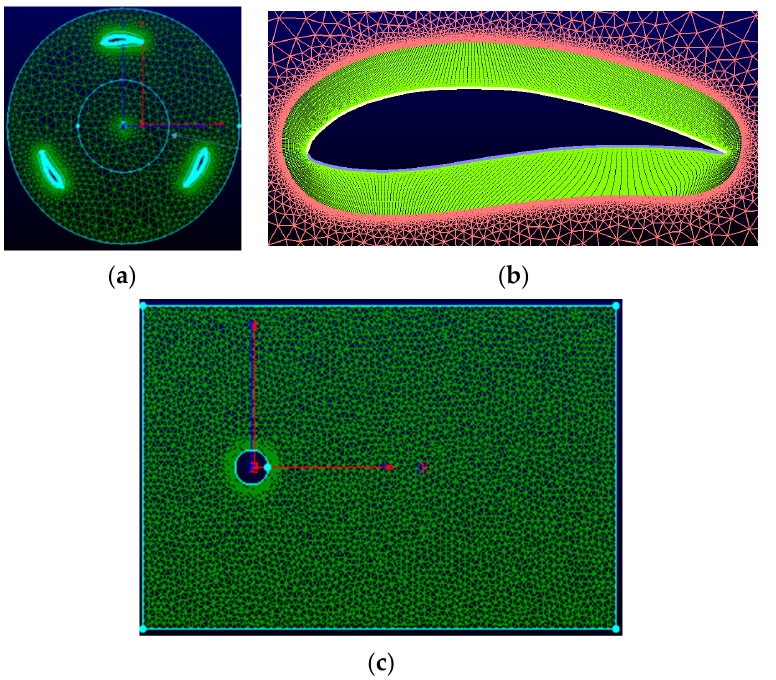
Figure 3. Dimensions and border conditions. ( a ) Rotational domain, ( b ) detail of the mesh close to the blade, ( c ) stationary domain.